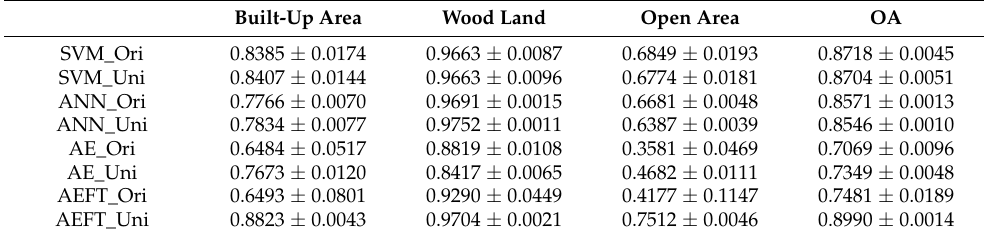
Table 9. Objective evaluation indicators of four classifiers on the normalized parameters and the original parameters of Touzi decomposition for Oberpfaffenhofen